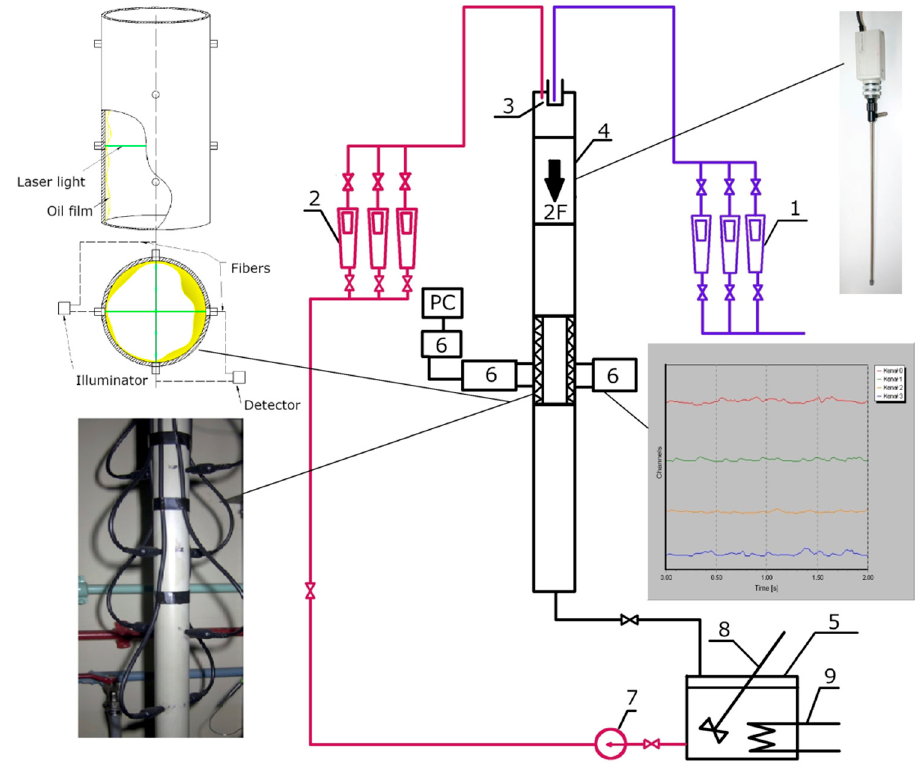
Figure 1. Test stand diagram: 1—rotameter of air, 2—rotameter of oil, 3—feeding chamber (central jet), 4—measuring channel, 5—oil tank, 6—system of optoelectronic sensor, 7—pump, 8—mixer, 9— heater.